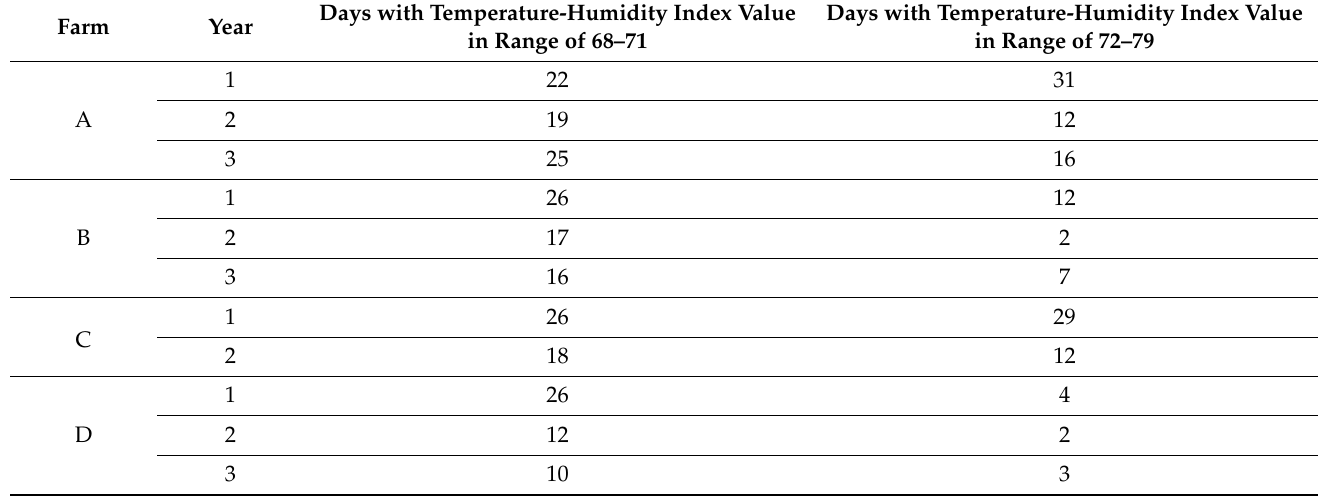
Table 4. Number of days with the highest temperature-humidity index value.